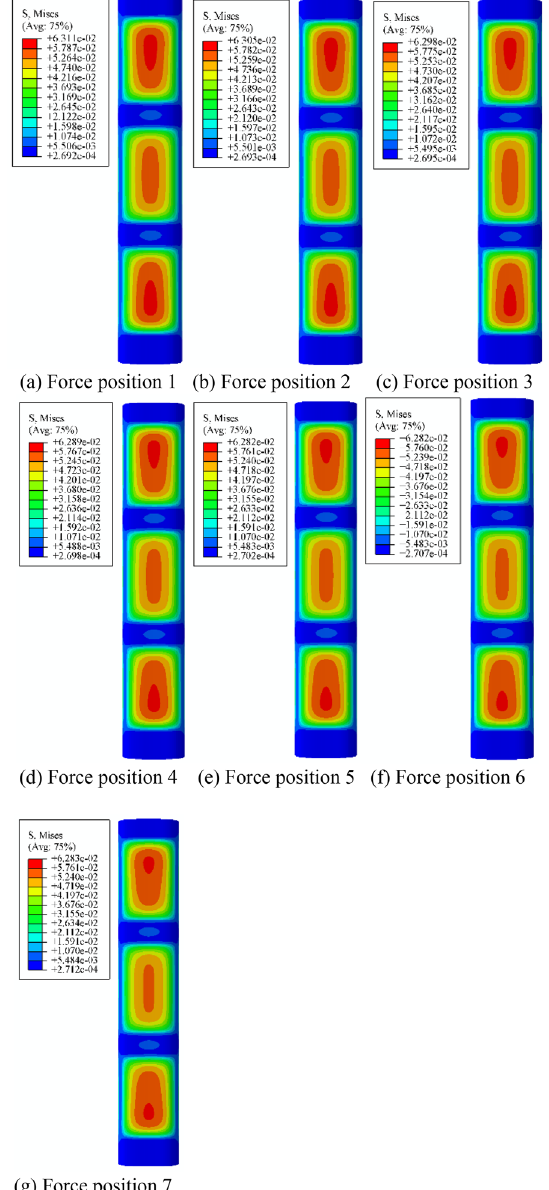
Figure 15 Distribution of contact stress at different force position: a Force position 1; b Force position 2; c Force position 3; d Force position 4; e Force position 5; f Force position 6; g Force position 7